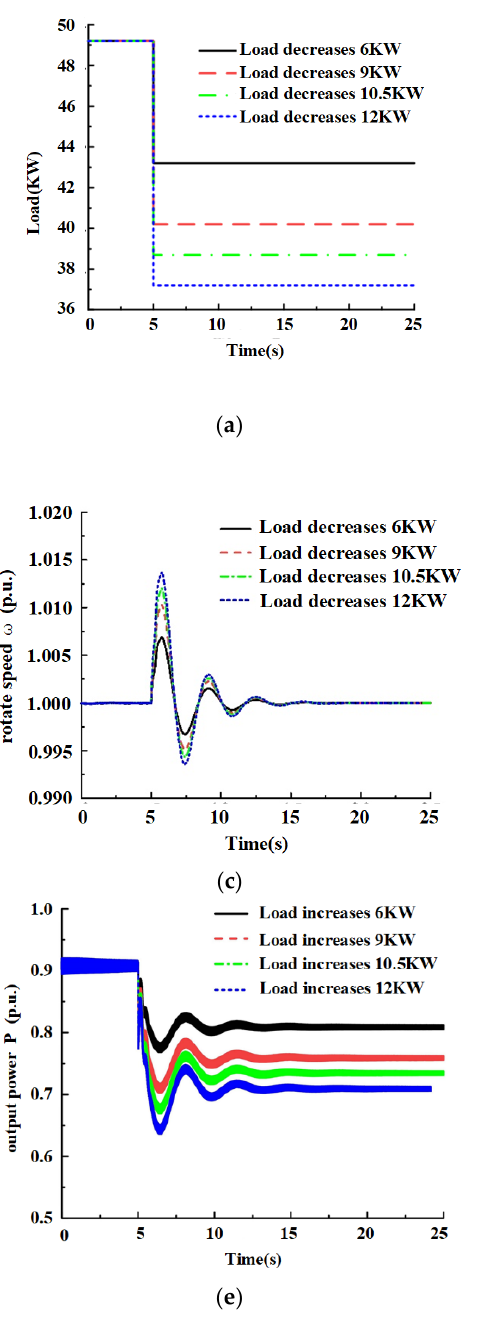
Figure 14. Simulation curve of the system response under a sudden decrease of load. ( a ) The demand load decrease curve. ( b ) System frequency response curve. ( c ) Conventional generator speed response curve. ( d ) The rotor-speed response curve. ( e ) Conventional generator output active power response curve. ( f ) Wind-driven generator output active power response curve.